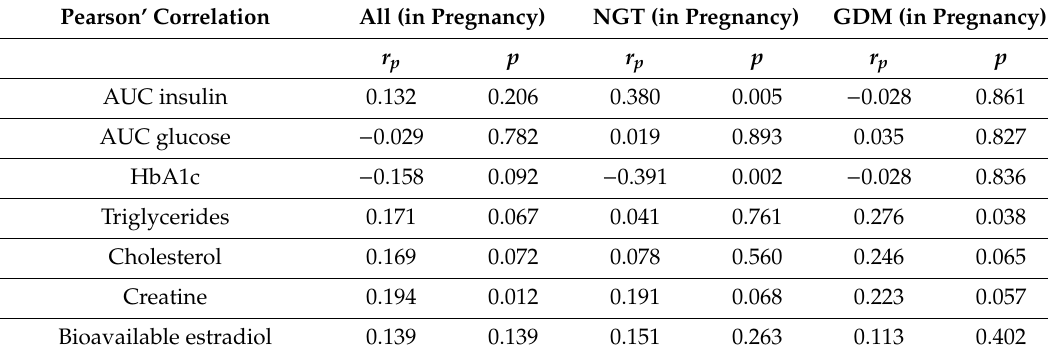
Figure 4. Grouped scatter dot plot according to glucose tolerance (blue = NGT, red = GDM) depicting the correlation of secretagogin (SCGN) (log-transformed) with week of gestation during pregnancy between week of gestation (GW) 10 and 28. In women with GDM, SCGN correlated positively with week of gestation ( r p = 0.308, p = 0.021). NGT displays the same trend, albeit not statistically significant ( r p = 0.035, p = 0.791). NGT: normal glucose tolerance; GDM: gestational diabetes mellitus.